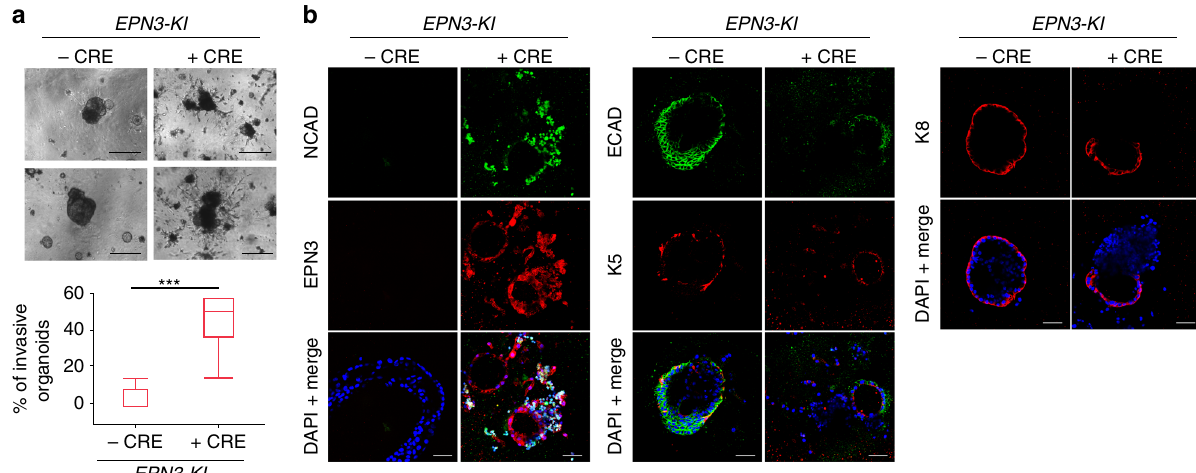
Fig. 3 EPN3 overexpression induces an invasive phenotype in primary organoids. a Bilayered primary organoids were obtained from the mammary gland of six EPN3-KI mice and treated in vitro (or mock-treated) with Cre. Top, bright- fi eld images. Bar, 270 μ m. Bottom, quanti fi cation of invasive organoids over total is presented as box plots ( N = 90 for -Cre and N = 100 for + Cre). Here and in other fi gures, each box plot is de fi ned by 25 and 75 percentiles, showing median, whiskers representing 10 and 90 percentiles and outliers if present. P value, Student ’ s t test, two-tailed. b Bilayered organoids generated as in panel a were subjected to IF with Ab against NCAD, ECAD, EPN3, keratin 5 (K5), keratin 8 (K8). Blue, DAPI. Bar, 45 μ m. Source data are provided as a Source Data fi